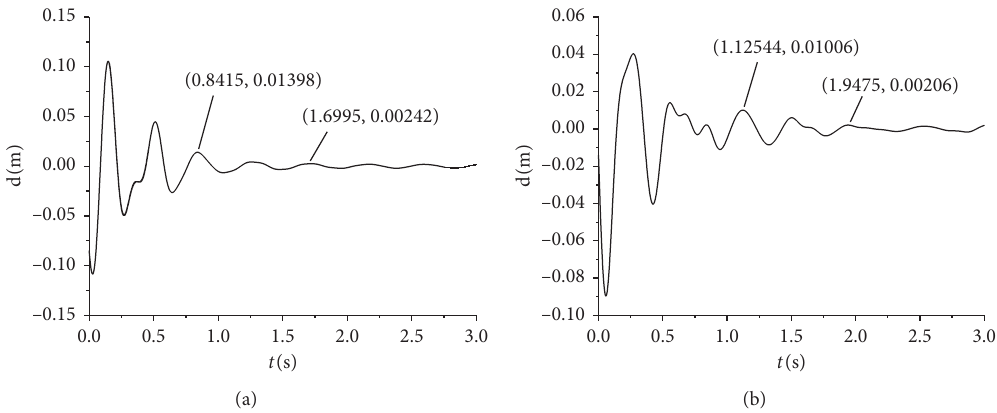
Figure 8: Displacement time-history curves of spring-rubber isolation device. (a) TXJG1. (b) TXJG2.